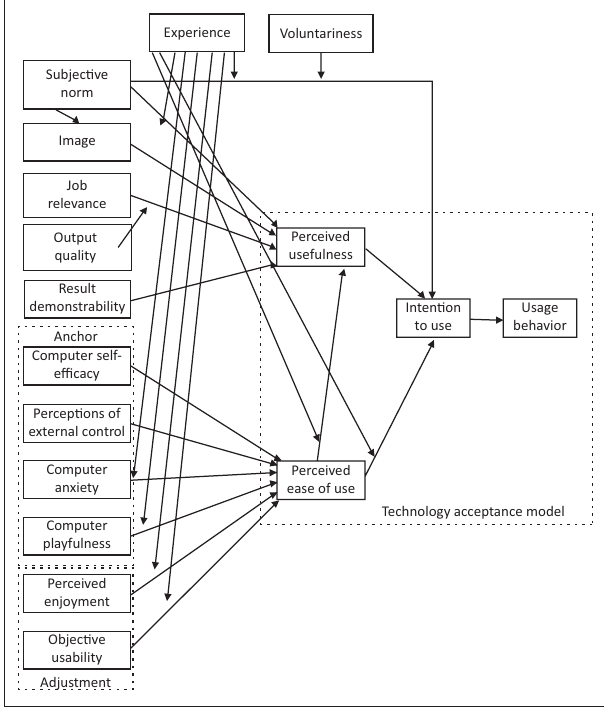
FIGURE 4: Technology Acceptance Model